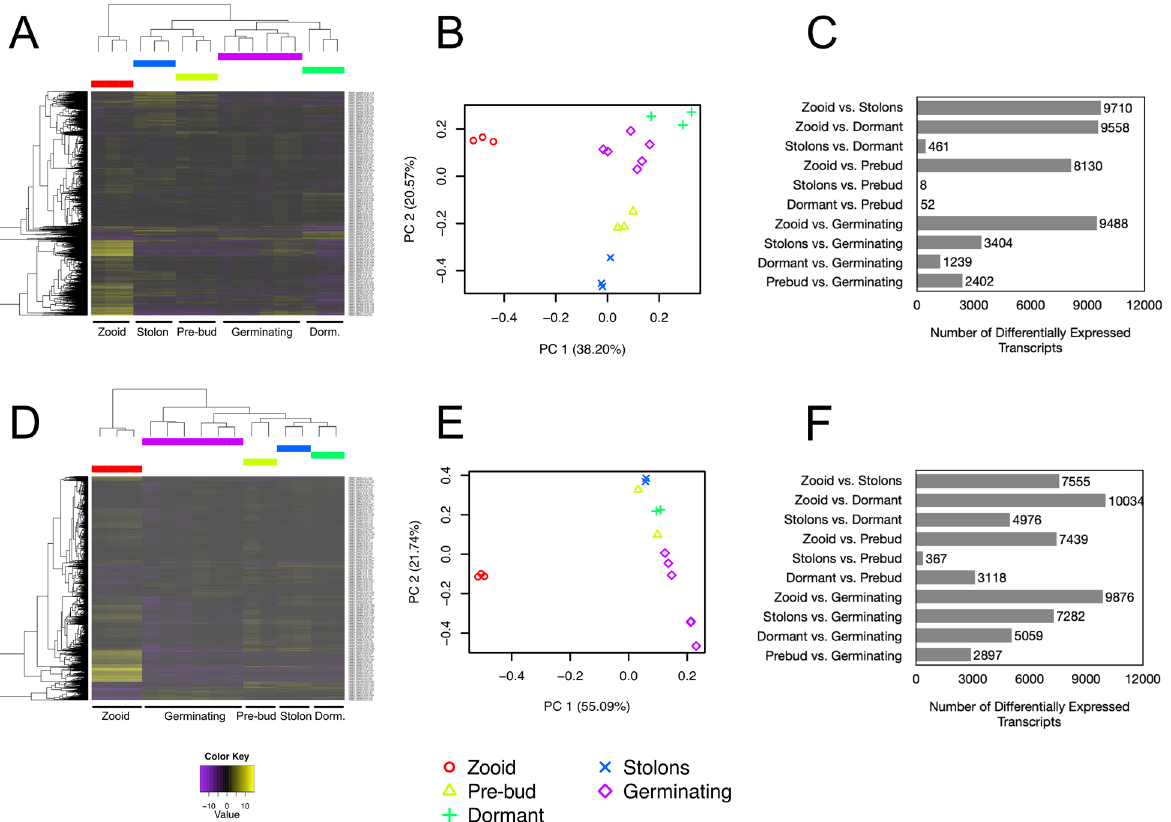
Figure 9. Differentially expressed transcripts during life stages in Polyandrocarpa zorritensis and Clavelina lepadiformis. Heatmaps of differentially expressed transcripts across samples: ( A ) P. zorritensis and ( D ) C. lepadiformis ; each row represents expression value of a single transcript as shown in the color key below plots, violet indicates low expression and yellow indicates high expression; columns show clustered life stage replicates, bars in red = zooid, blue = stolon, yellow = pre-bud, green = dormant, and magenta = germinating stage. Principal Component Analysis showing relationships among and across samples: ( B ) P. zorritensis and ( E ) C. lepadiformis . Key below indicates colored symbols for each life stage sample type. Number of differentially expressed transcripts in each pairwise comparison between sample types for each species: ( C ) P. zorritensis and ( F ) C. lepadiformis .